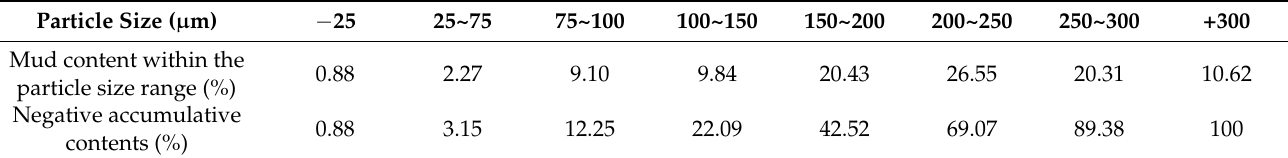
Table 2. Distribution of particle sizes of quartz sand.